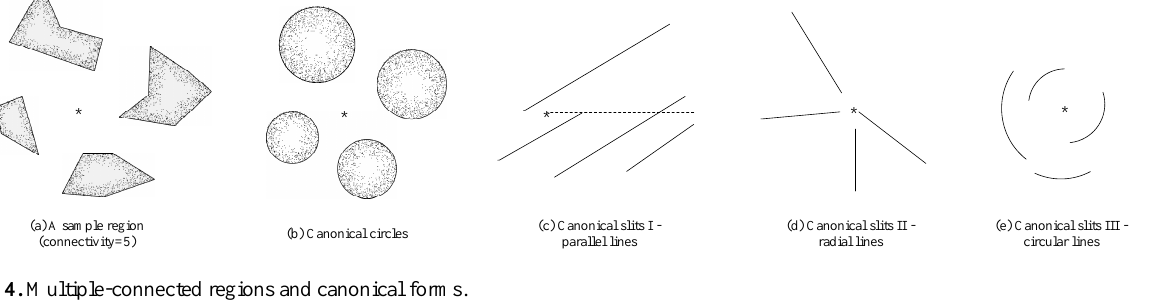
Figure 4. Multiple-connected regions and canonical forms.